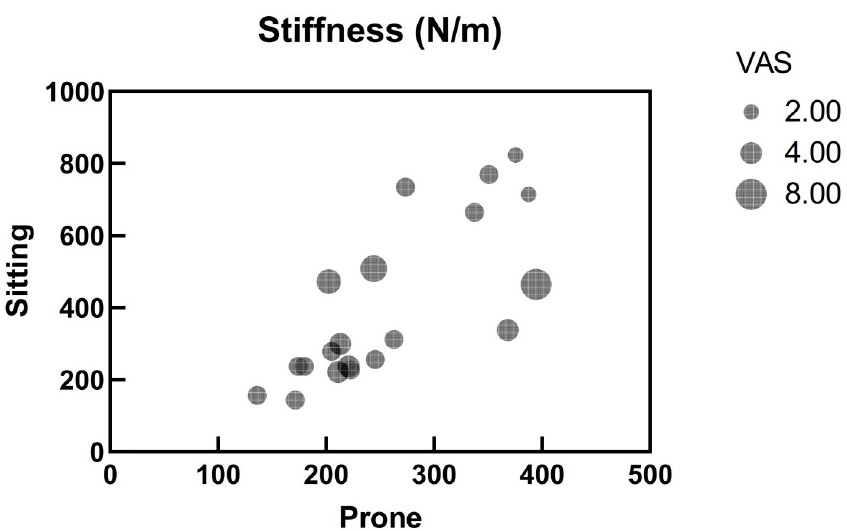
Fig 4. Bubble chart of relationships between visual analog scale (VAS) and erector spinae stiffness on the painful side in prone and sitting ( N = 20).